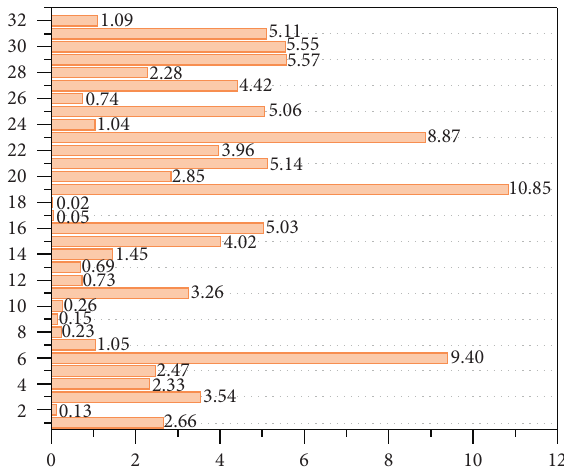
Figure 8: The value of the normalized feature